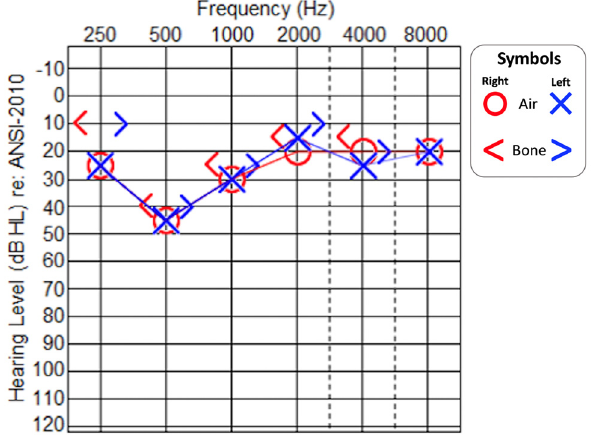
Figure 1. Pure − tone audiogram at 7 years of age in afebrile state. Red line: right ear. Blue line: left ear. Vocal audiometry detected a slight decrease bilaterally in vocal discrimination. The child’s disyllabic word recognition was 100% in a quiet environment, 90% with a signal- to-noise ratio (SNR) of + 10 and + 5, and 70% with a SNR of 0. With the Italian Simplified Matrix Test [18], the patient’s speech reception threshold (SRT) was + 5.5. The child also presented specific phonological difficulties in the discrimination of the vowels /a/ and